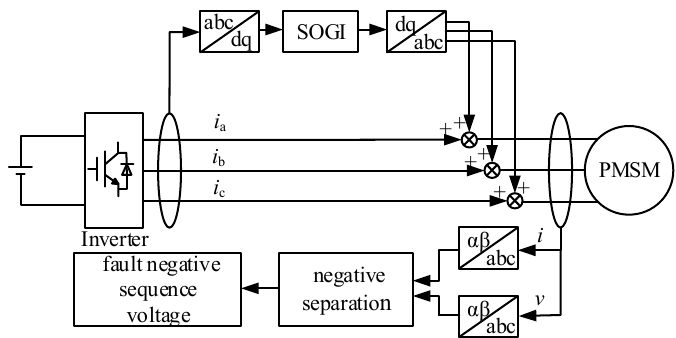
Figure 3. Basic structure of fault diagnosis.